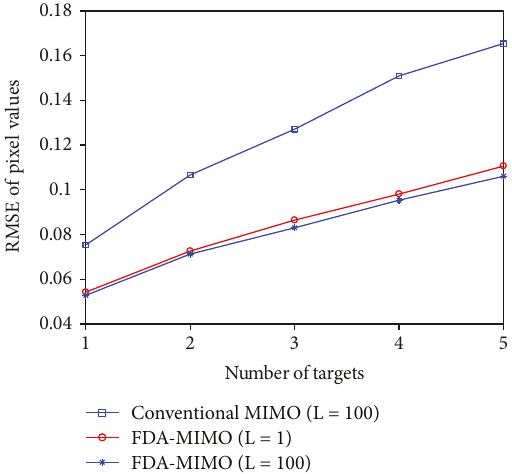
Figure 7: RMSE of pixel values in nontarget